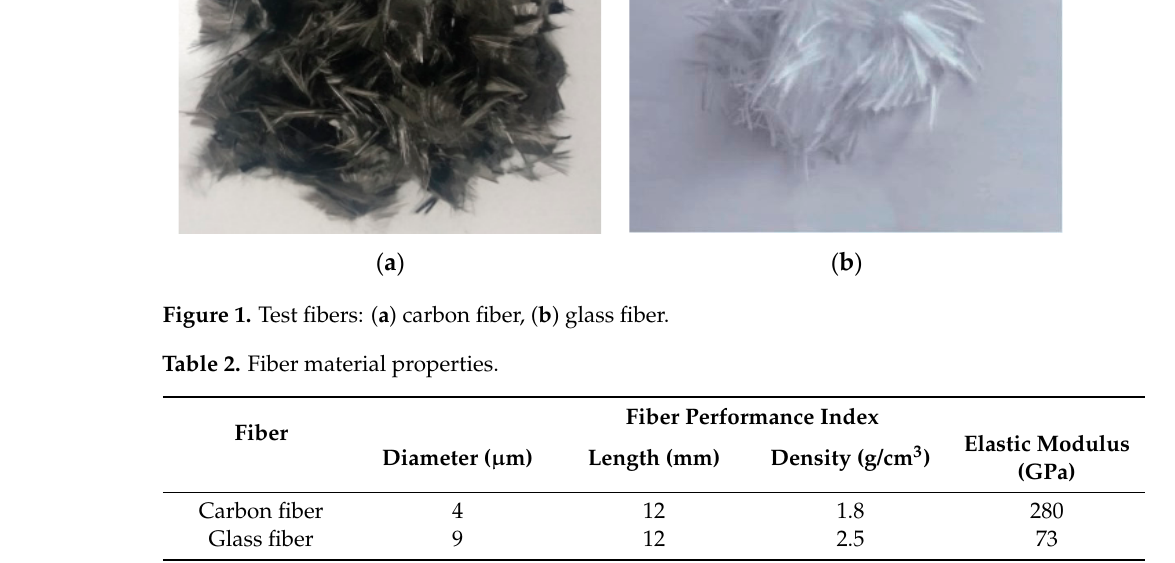
Table 3. Specifications and parameters of steel hinge lines.